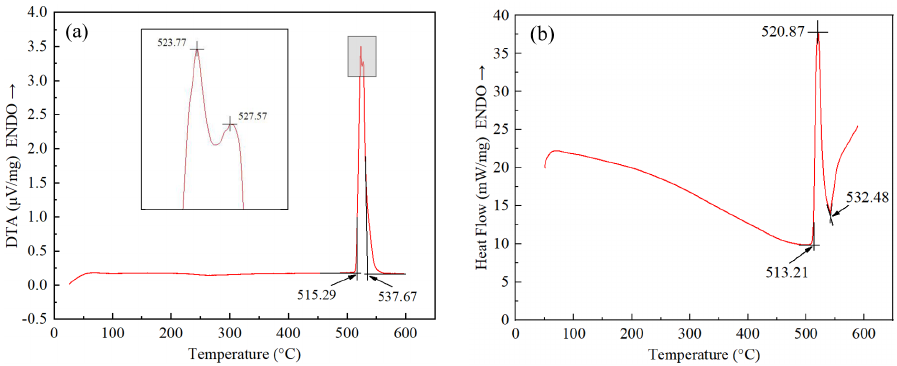
Figure 4. DTA and DSC curve of Al ‐ 5.0Si ‐ 20.5Cu ‐ 2.0Ni alloy in different condition: ( a ) As ‐ cast con ‐ dition; ( b ) Melt ‐ spun ribbon.